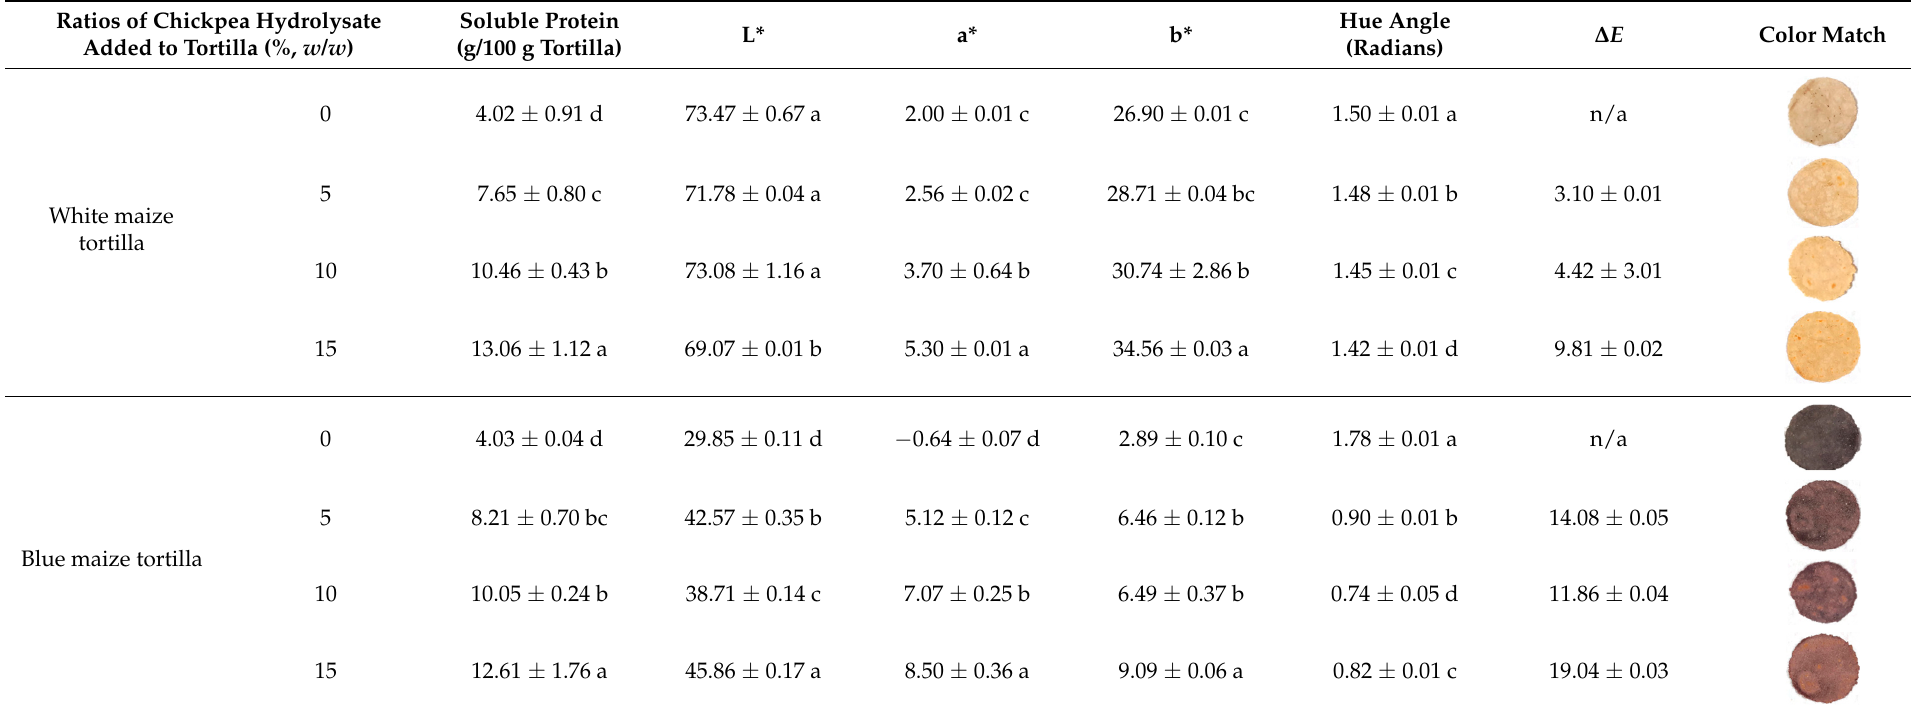
Results show the mean soluble protein concentration and color values ± standard deviation. Different letters indicate significant differences ( p < 0.05) among fortification treatments. L* = lightness value. a* = axis is relative to green–red opponent colors (negative values = green, positive values = red). b* axis represents blue–yellow opponents (negative numbers = blue, positive = yellow).